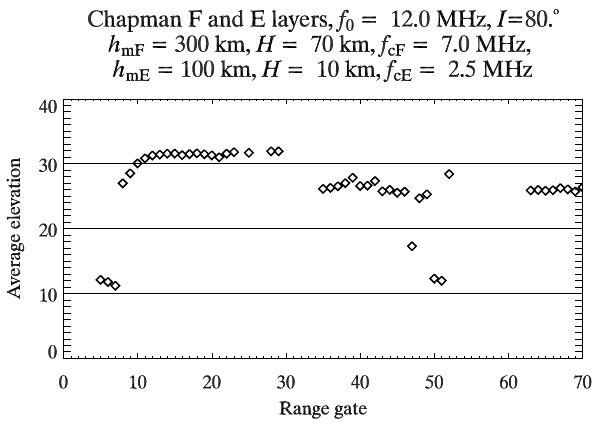
Fig. 7. Effective scatter volume locations (black diamonds) for the more realistic simulation presented in Fig. 6. The yellow colour corresponds to the 1 ◦ aspect areas. Data with power level ≤− 40dB with respect to the maximum power are not shown (see text for comments).